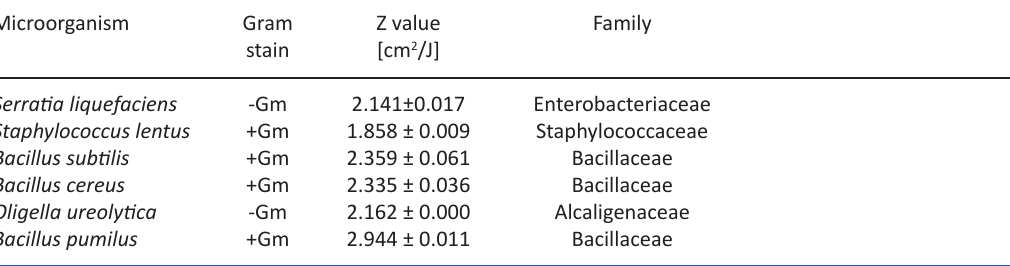
Table 2. Z-values for different bacteria for 300 s of UVGI exposure at 15-cm distance of exposure Microorganism Gram Z value Family stain [cm 2 /J] Serratia liquefaciens -Gm 2.141±0.017